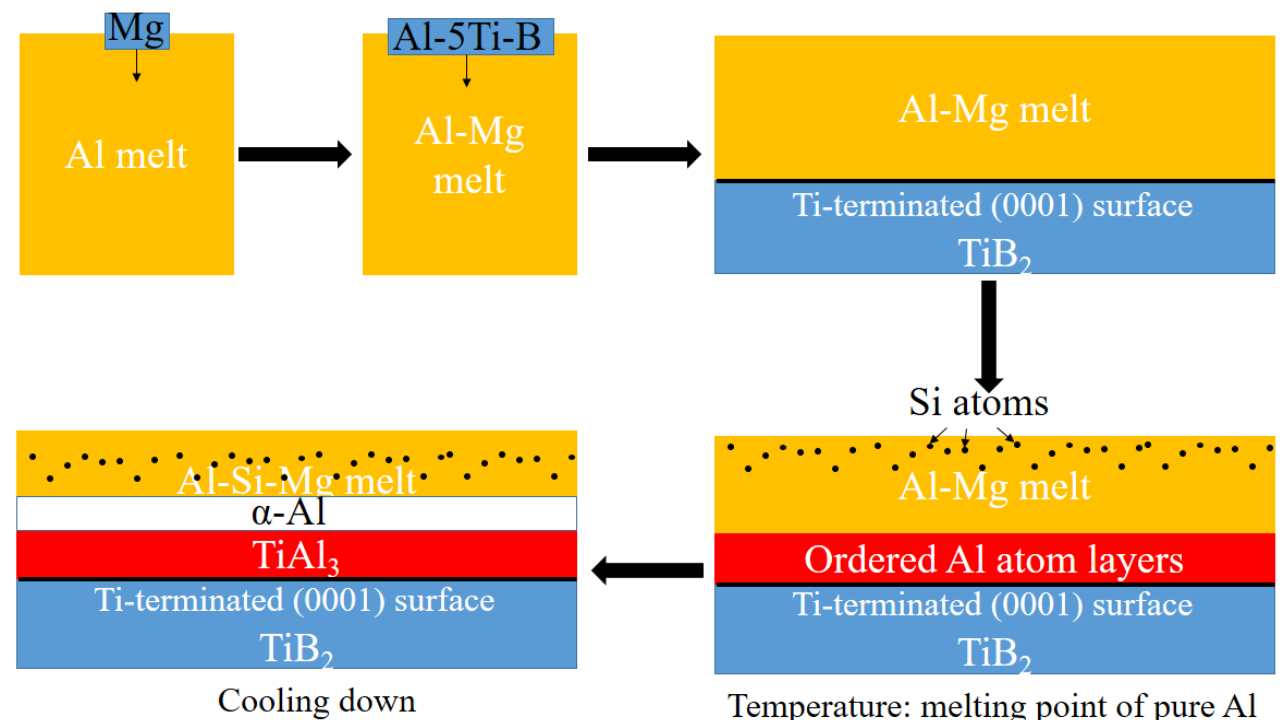
Figure 1. Schematic diagram of “pre-refinement” design concept.